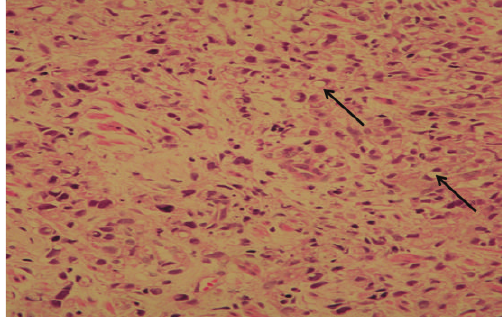
Figure 5: Histopathology of a biopsy form edge of the gastric ulcer shows signet-ring-cell infiltrate (arrows) consistent with gastric adenocarcinoma. (Hematoxylin and eosin staining; magnification ×